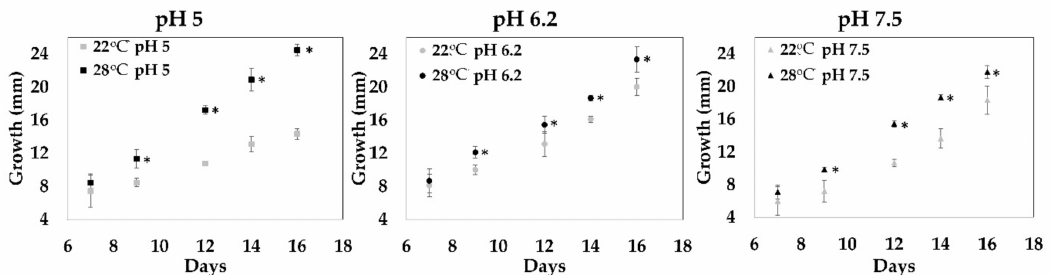
Figure 1. E ff ect of pH and temperature on Inonotus obliquus growth. I. obliquus was grown on a yeast malt agar medium (YMA) in Petri dishes for 16 days at 22 or 28 ◦ C. YMA pH was adjusted with addition of an HCl or NaOH solution to obtain final pHs of 5, 6.2 and 7.5. Diameter (in mm) corresponding to fungal growth was measured every two days starting at day seven. Results represent the average ( ± error bars) growth of three biological repetitions per condition. Statistical significance is annotated with an asterix (*), according to ANOVA test results with p <